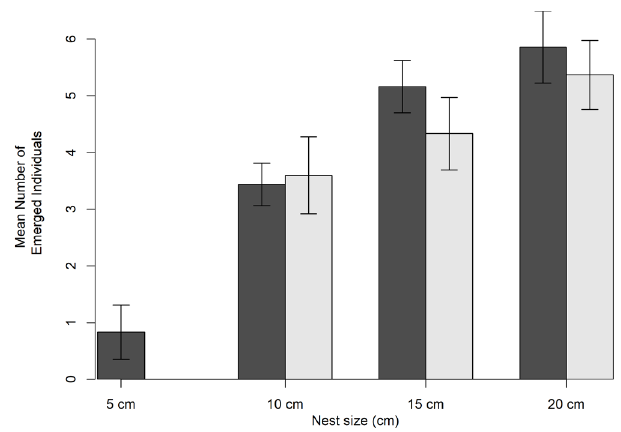
Fig 3. Mean number of emerged adults in trap-nests of different lengths. Centris analis (= dark gray bars), Tetrapedia diversipes (= light gray bars).